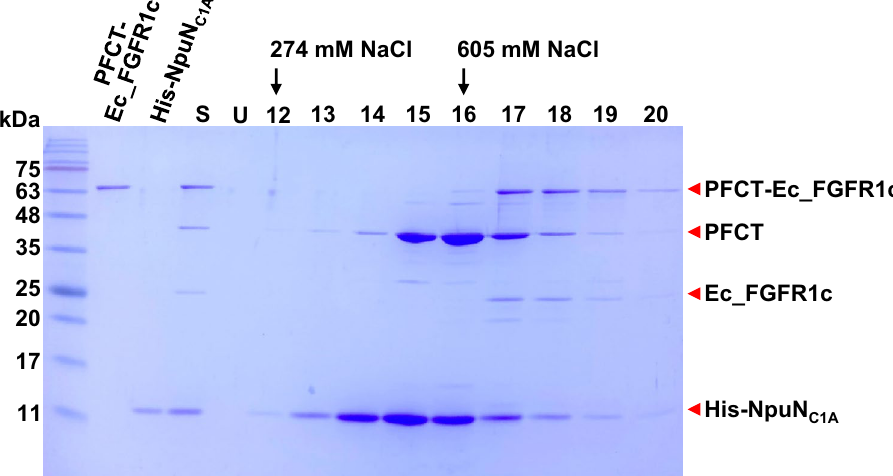
Figure 6. Elution profile analyses of the fibroblast growth factor receptor 1c (FGFR1c) isoform via affinity purification using heparin resin. As an intrinsic feature of binding affinity to heparin, the separated Ec_FGFR1c from PFCT-Ec_FGFR1c was eluted using approximately 605 mM NaCl. A similar elution profile was also shown by the PFCT-Ec_FGFR1c fusion protein that remained in the column. Red arrows indicate whole and